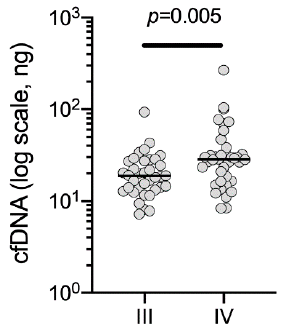
Figure 1. Total yield of cfDNA per patient for stage III vs. stage IV melanoma patients.